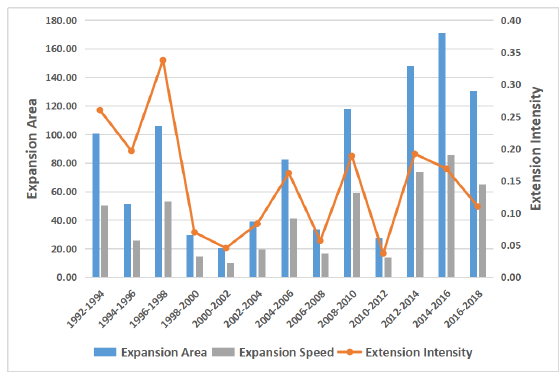
Figure 11. An expandsion area, speed, and intensity line